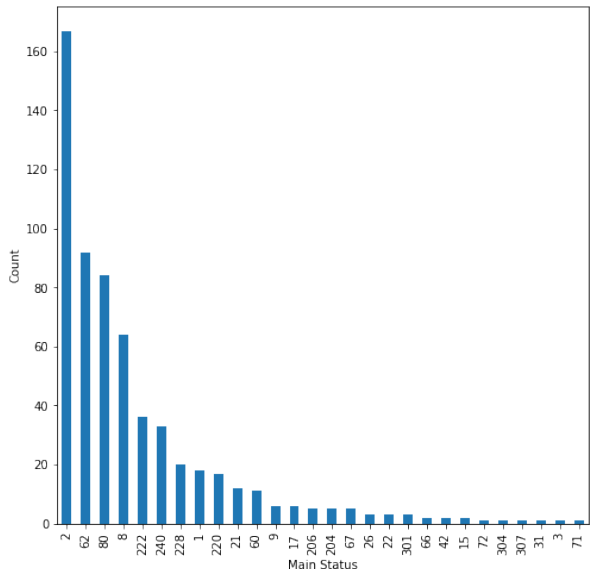
Figure 5. Count of all status